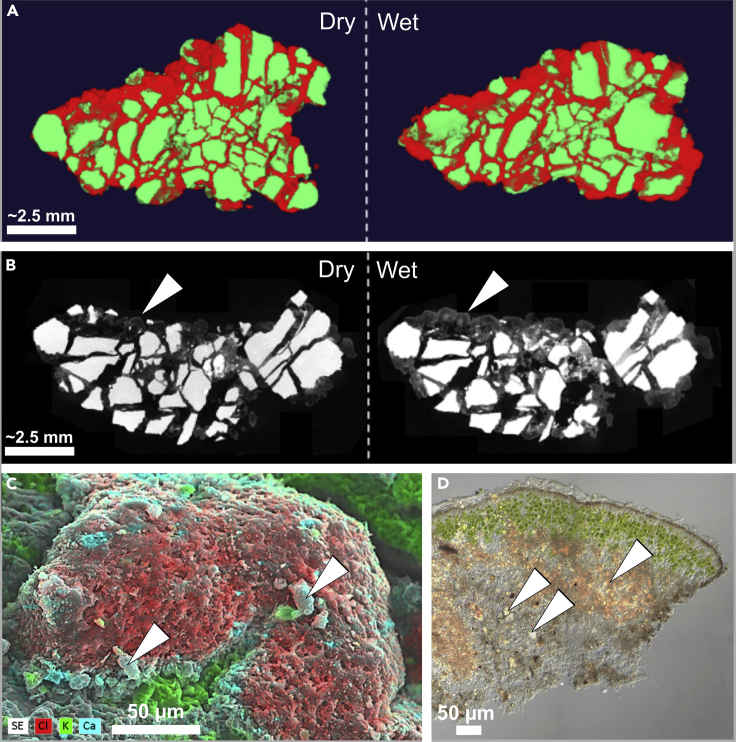
Effects of Fog and Dew Induced Wet-Dry Cycles and Mineral Accumulation on Colonized Black Grit(A) Schematic output of the segmented 3D model for the grit before (left) and after wetting (right). While the stones (green) did not change their volume, the lichen tissue (red) showed a considerable increase in volume, which is especially obvious for the inner regions between the stone fragments.(B) Gray scale tomograms of the grit before (left) and after wetting (right). Arrows indicate regions where swelling of the lichen tissue was most pronounced.(C) Artificially colored SEM-EDX image showing the presence of salts attached to a lichen thallus (arrowheads); (D) Microscopic cross section of lichen thallus showing incorporated minerals (arrowheads) as weathered residues. SEM, scanning electron microscopy; EDX, energy-dispersive X-ray spectroscopy.